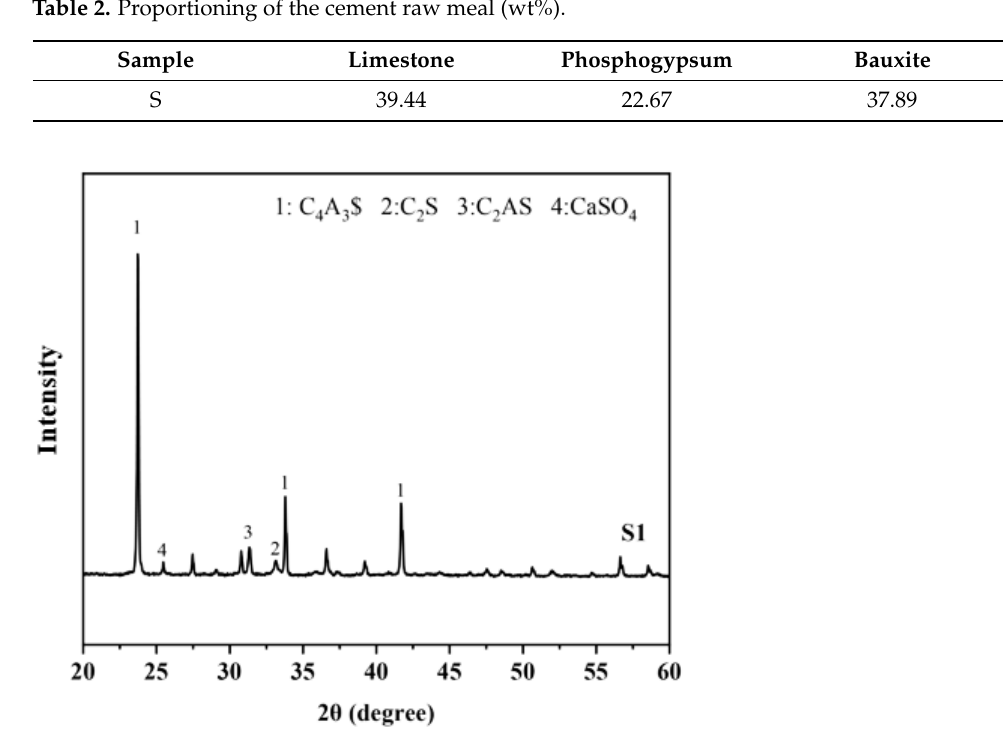
Figure 1. XRD pattern of the clinkers calcined at 1250 ◦ C for 60 min. Table 3. Contents of cement clinker minerals (wt %).